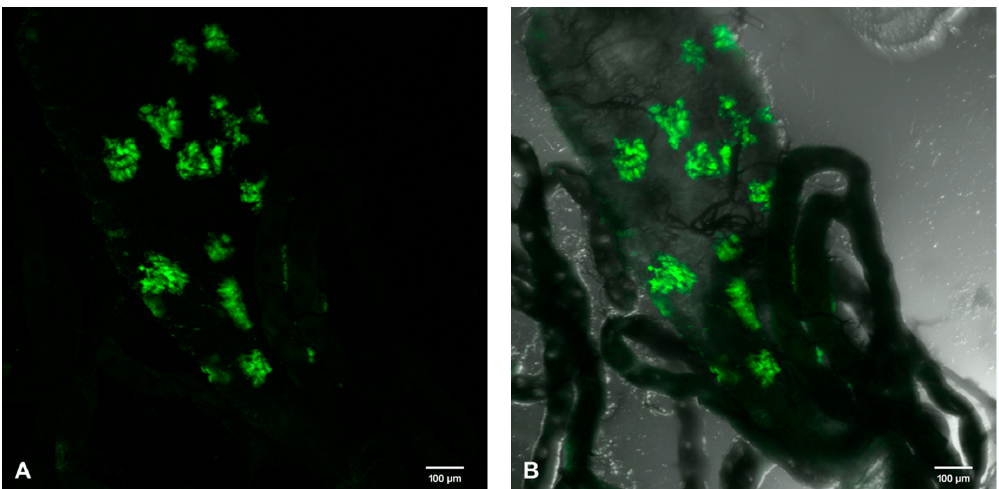
Figure 9. Multiple GFP (green) foci in PMG region of female mosquito D7 p.i. Female mosquitoes